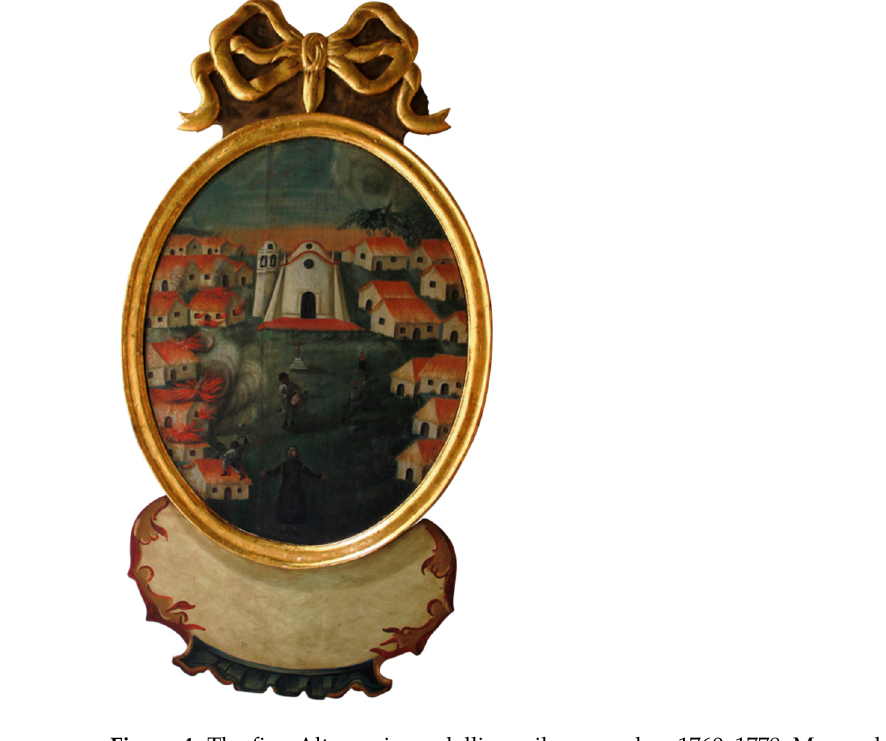
Figure 4. The fire, Altagracia medallion, oil on panel, c. 1760–1778, Museo de Altagracia, Higüey. Used with permission from Museo de Altagracia.